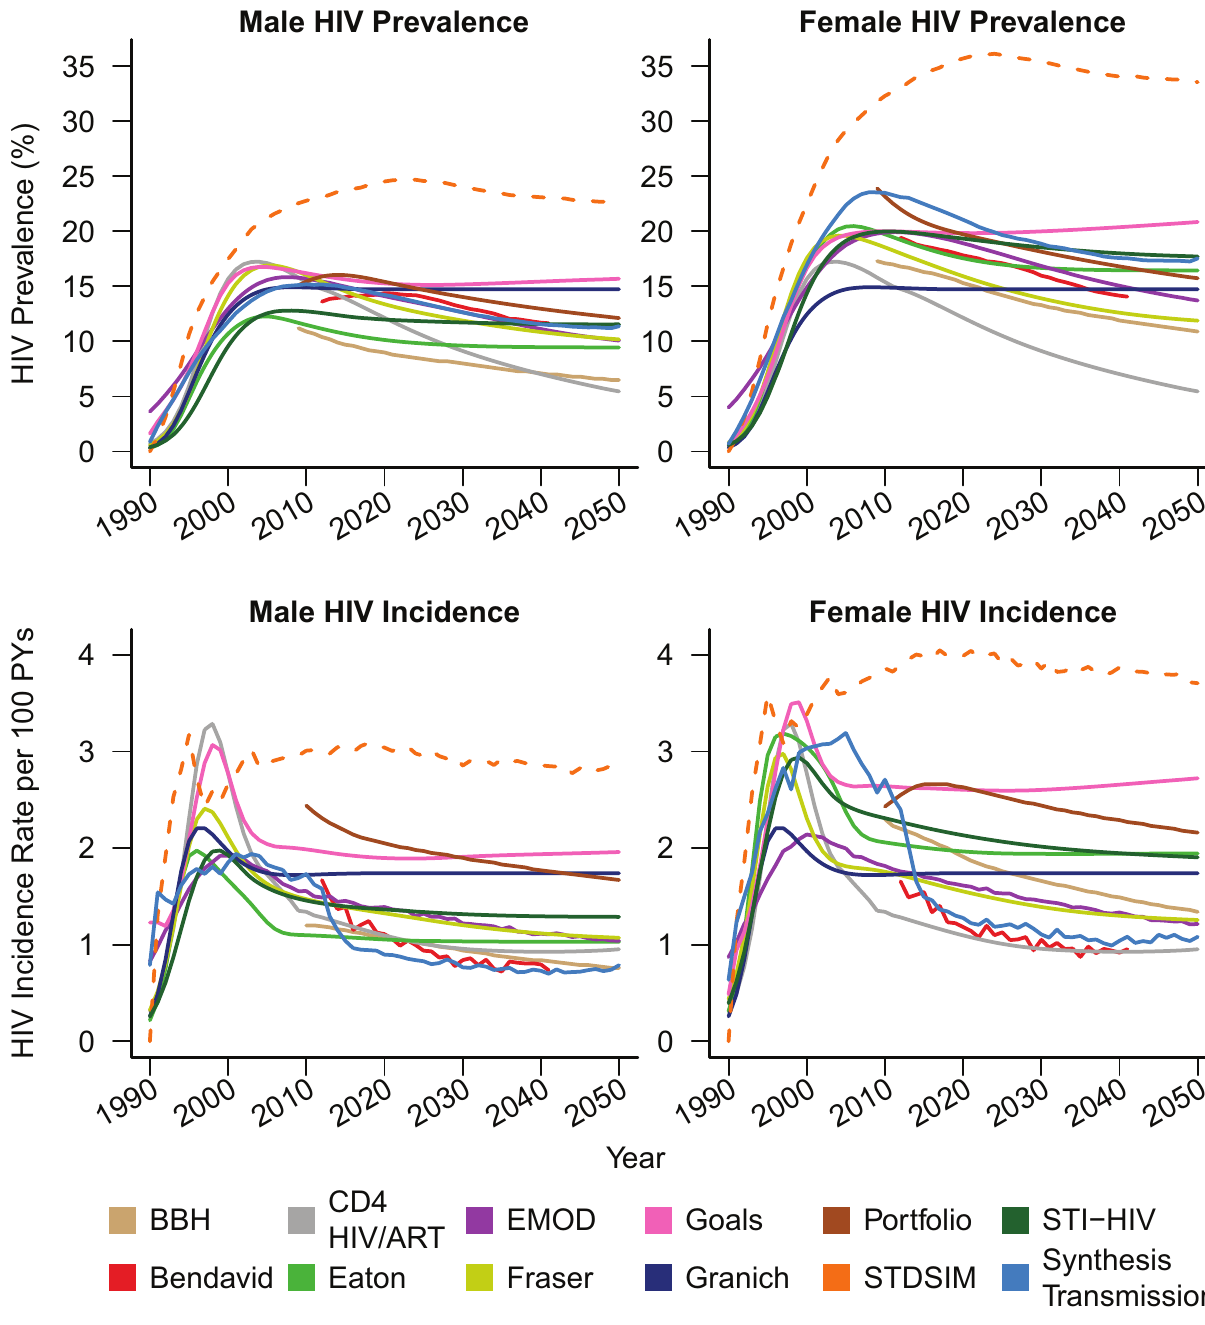
Figure 1. No-treatment counterfactual epidemic trends. Male (left) and female (right) HIV prevalence (top) and incidence (bottom) amongst 15- to 49-y-olds for counterfactual HIV epidemics with no ART. The STDSIM model is calibrated to a more severe epidemic in the Hlabisa subdistrict of KwaZulu-Natal Province, South Africa. The CD4 HIV/ART and Granich models do not stratify by sex, and the same prevalence and incidence curves are plotted for both sexes for these models. PYs, person-years. through ART provision to older adults who are less sexually active and hence less likely to expose susceptible individuals), whereas the other models did not assume reduced transmission by older people. (STDSIM allows for decreased sexual activity for those older than 50 and has the lowest estimate of person-years of ART per infection averted, but simulates a much higher HIV incidence.)